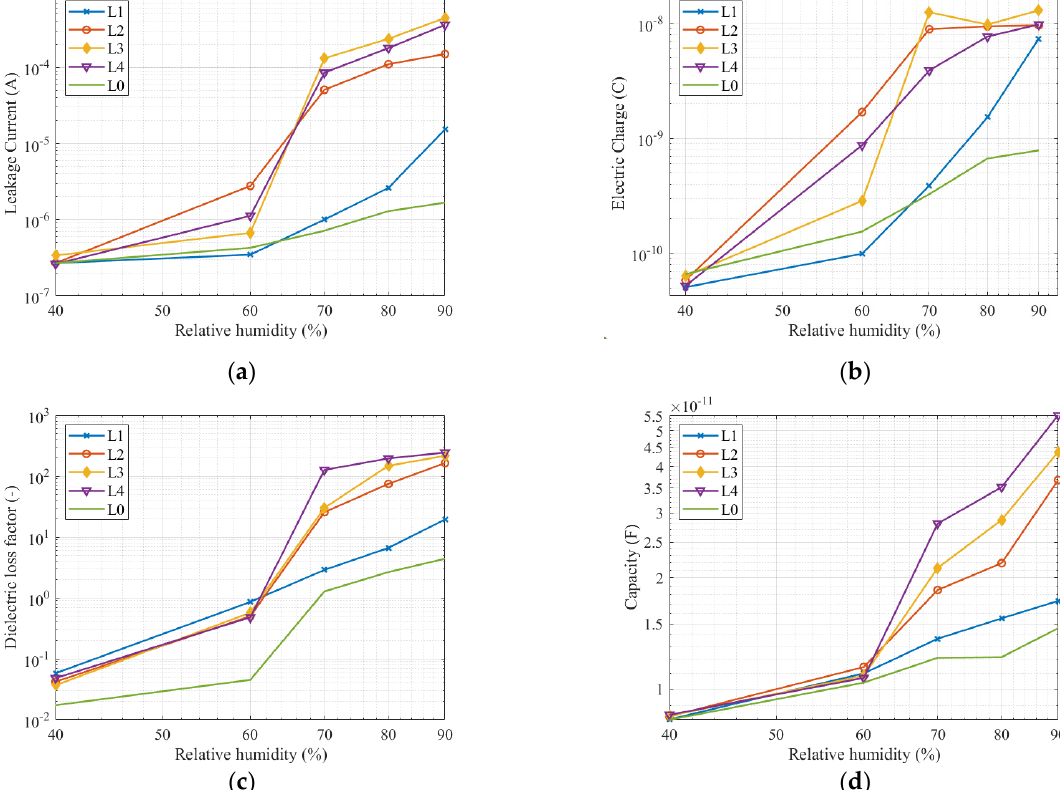
Figure 10. Measured quantities at frequency 1 kHz: ( a ) Leakage current; ( b ) Electric charge; ( c ) Di- lectric loss factor; ( d ) Capacity.